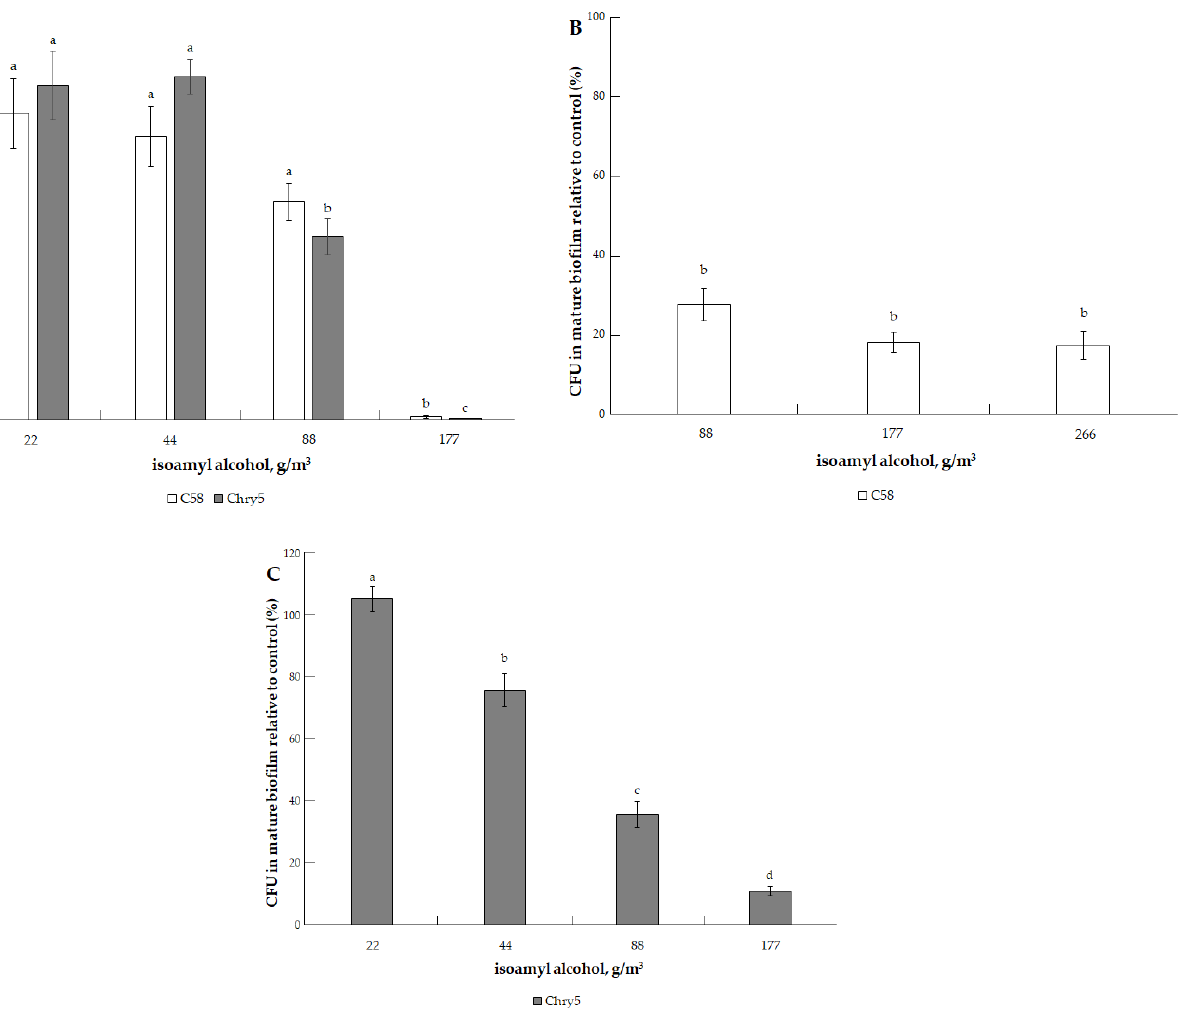
Figure 6. The effect of isoamyl alcohol on the formation of biofilm of A tumefaciens C58 (white column) and Chry5 (gray column) ( A ) and cell survival in mature biofilms of the C58 strain ( B ) and Chry5 strain ( C ) depending on the concentration of isoamyl alcohol. CFU of bacteria strains in the control (without VOC): 100 a %. The different lowercase letters above the mean values indicate significant differences ( p ≤ 0.05; Tukey’s HSD test).